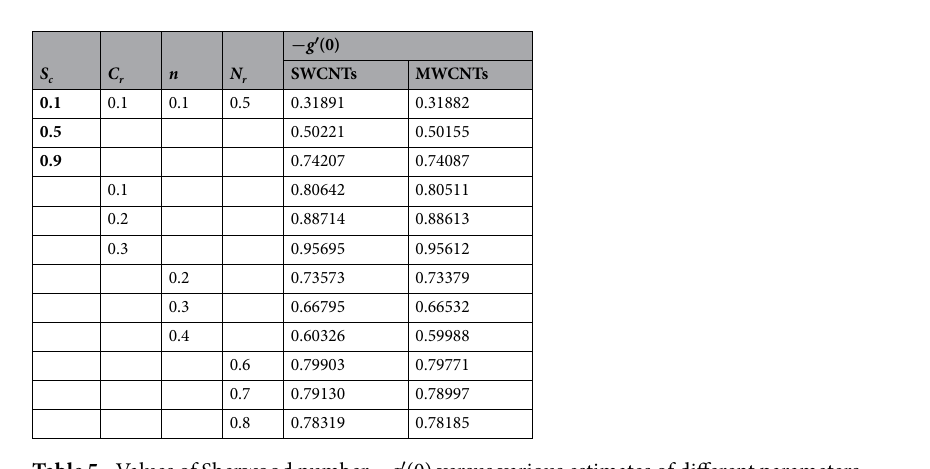
Table 5. Values of Sherwood number − g ′ (0) versus various estimates of different parameters.